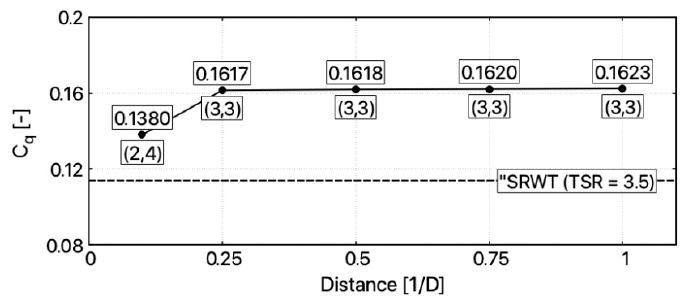
Figure 9. Power coefficient C p for optimal operational point for different configurations.